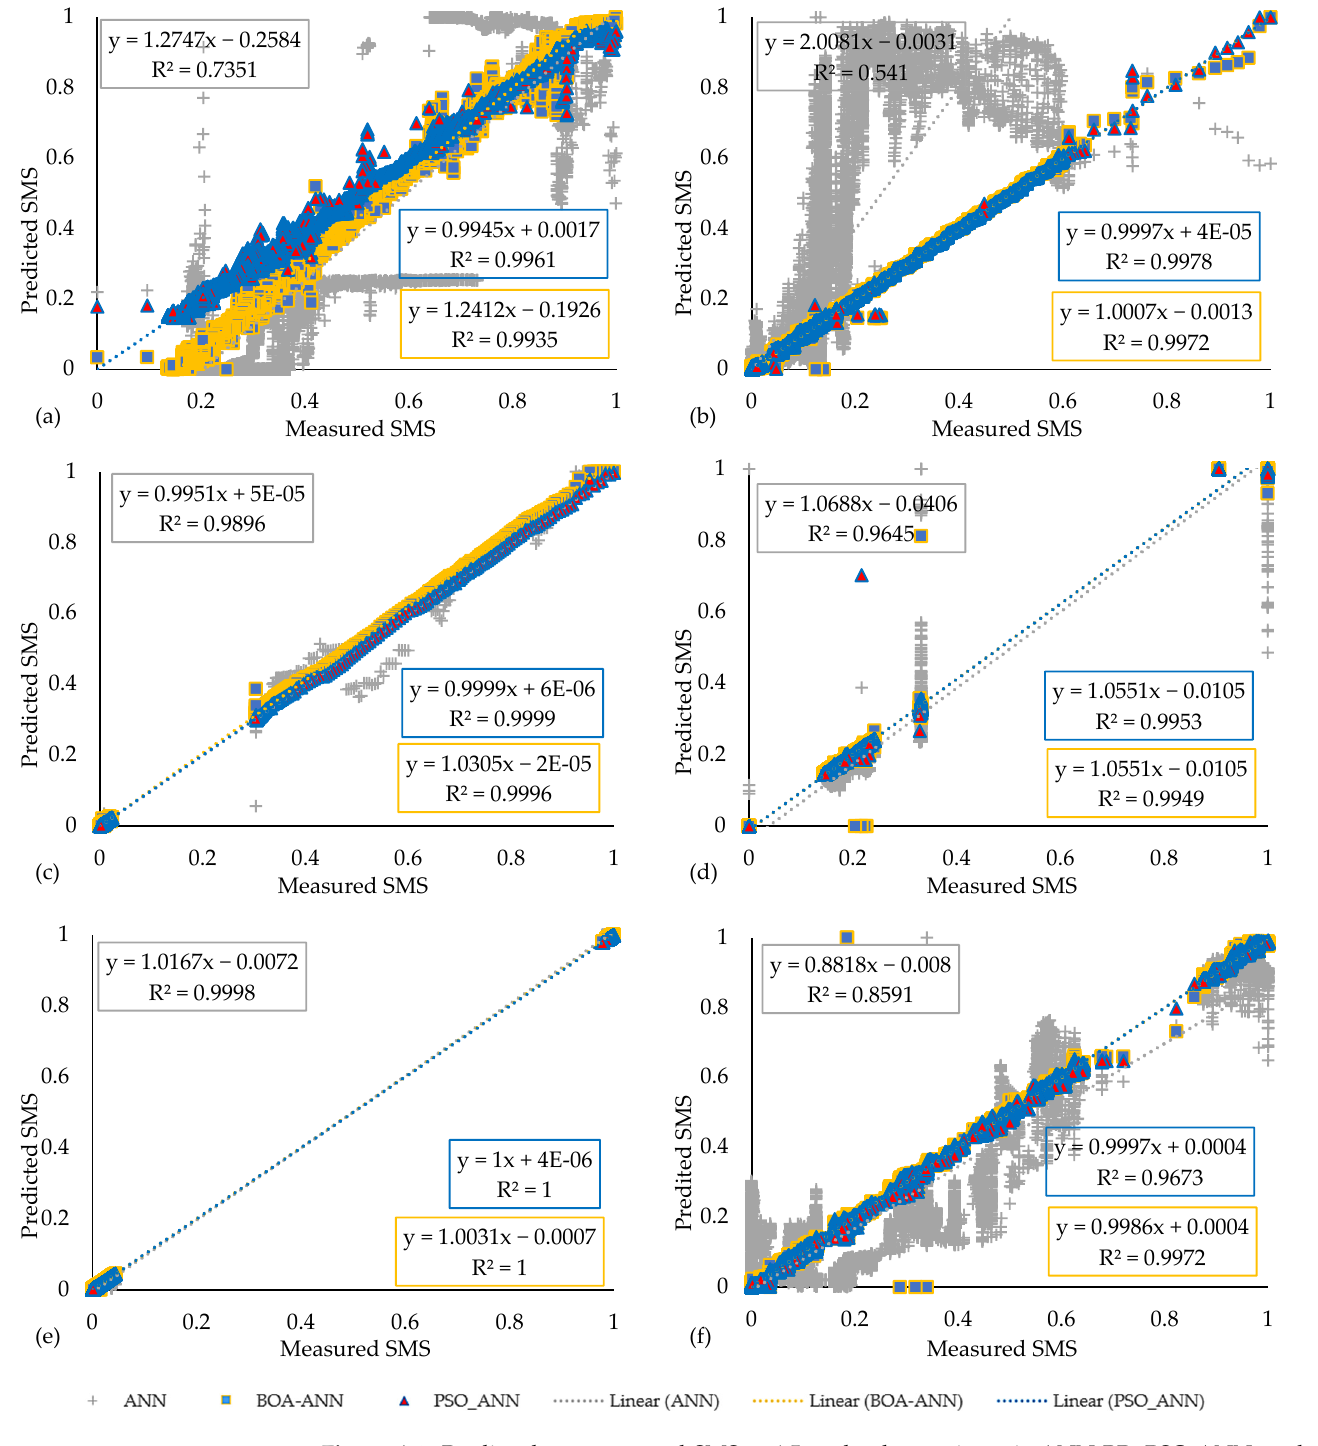
Figure A3. Predicted vs. measured SMS at 3 m depth overtime via ANN-BR, PSO-ANN, and BOA-